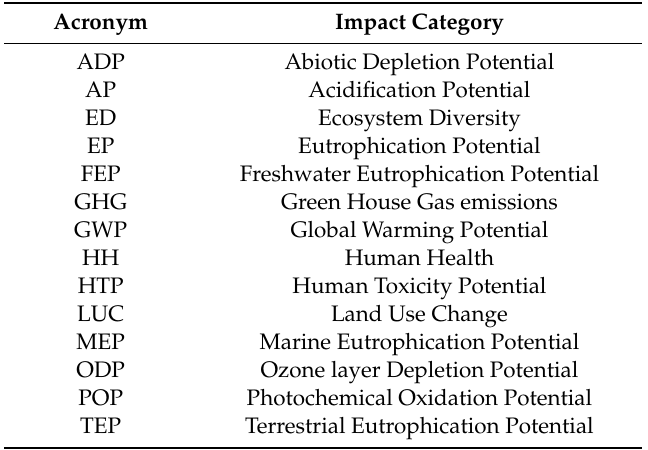
Table 1. Acronyms and definitions of the most common impact categories found in LCA